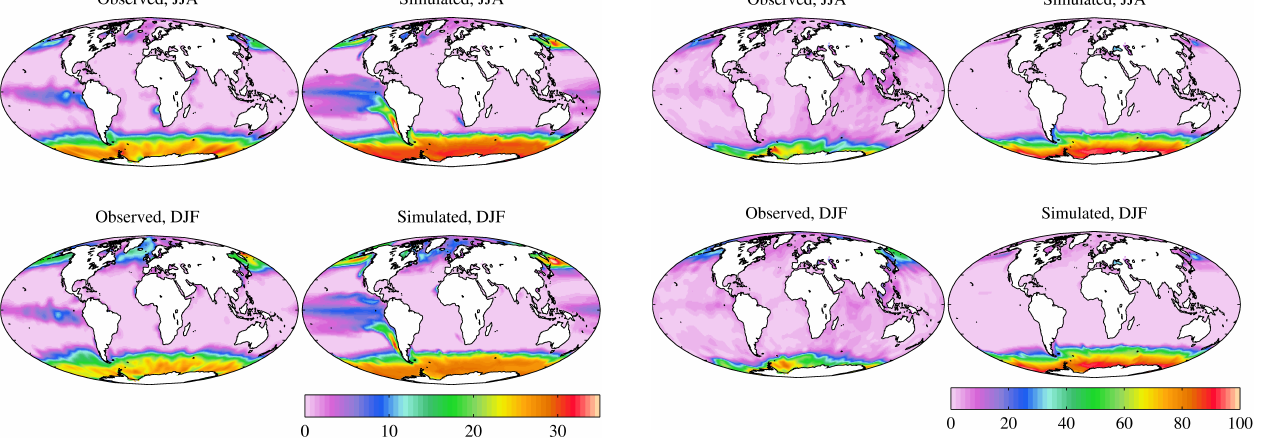
Fig. 5. Observational (World Ocean Atlas, 2009; left ) and simulated ( right ) surface silicic acid for northern summer (June–July–August; top ) and northern winter (December–January–February; bottom ). Concentrations in mmol m − 3 .